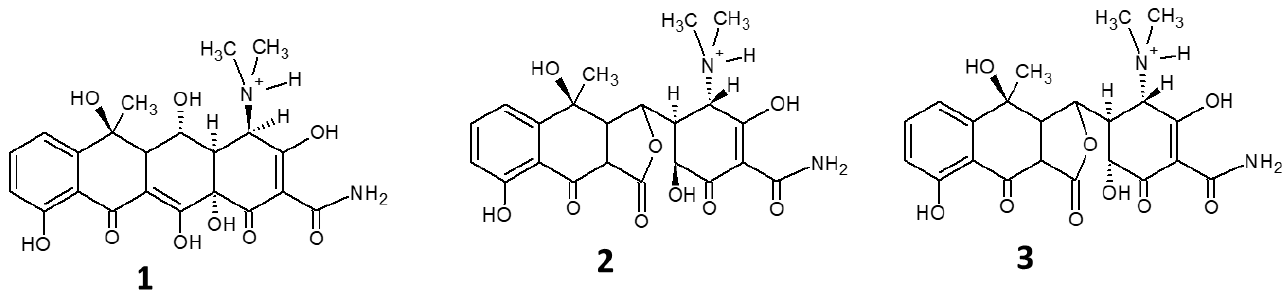
Figure 4. Structures of the main hydrolysis products of OTC, 4-epioxytetracycline ( 1 ), α-apooxytet- racycline ( 2 ) and β-apooxytetracycline ( 3